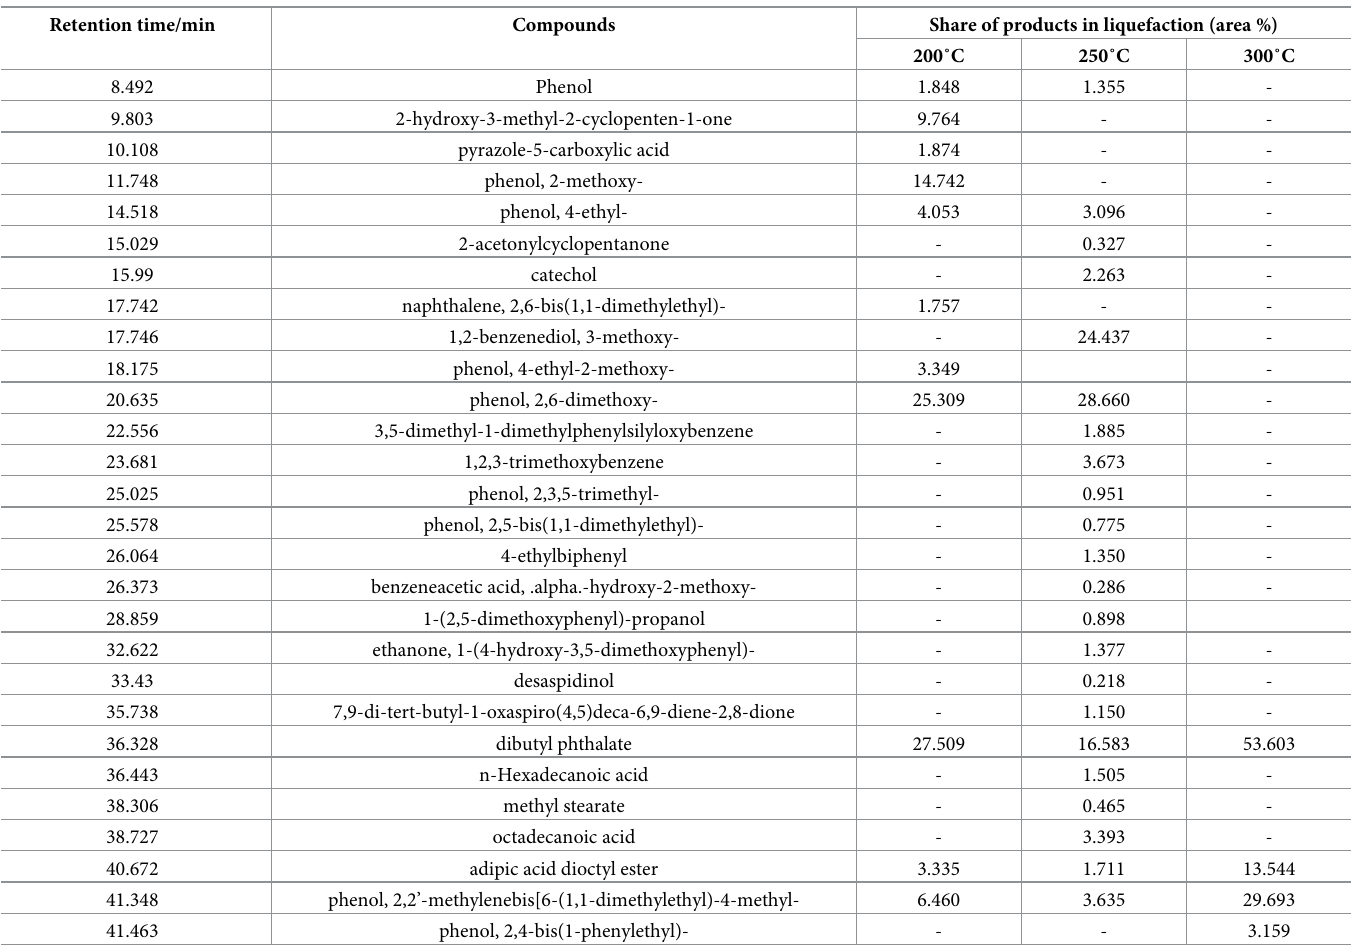
Table 2. Liquid organic products from HTC reactions of